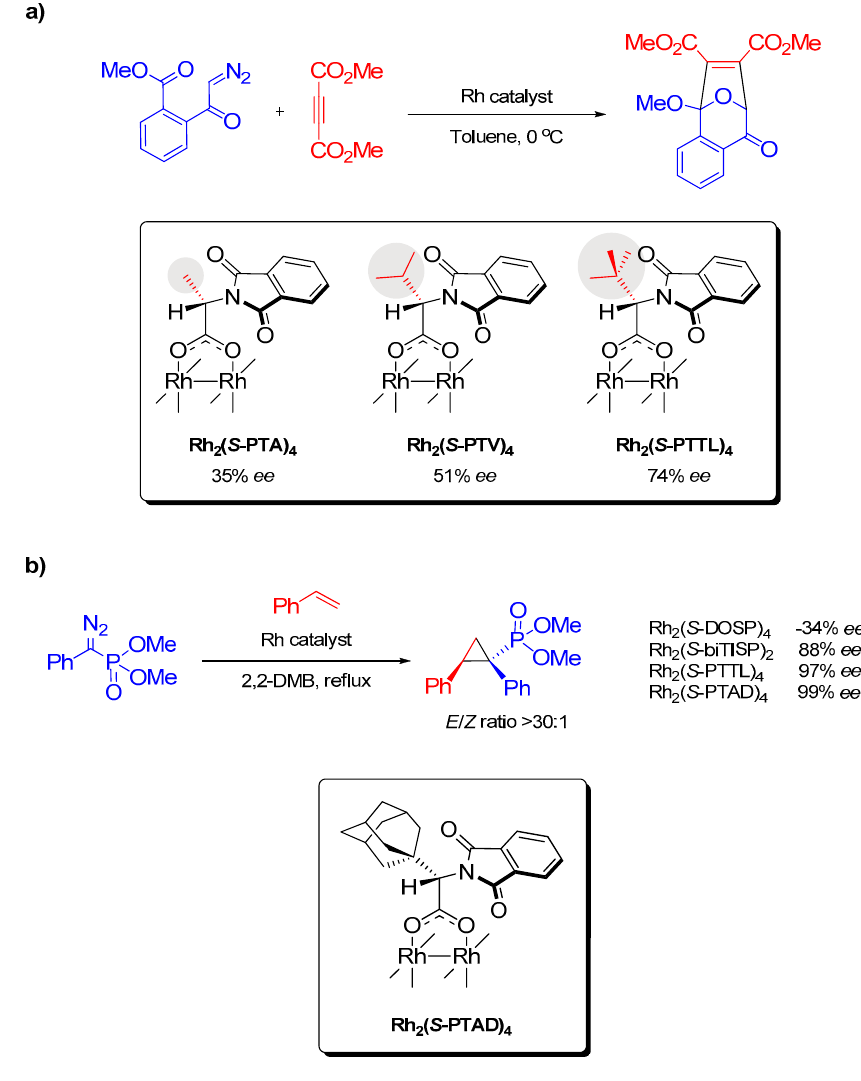
Dirhodium(II) ‐ catalyzed enantioselective tandem carbonyl